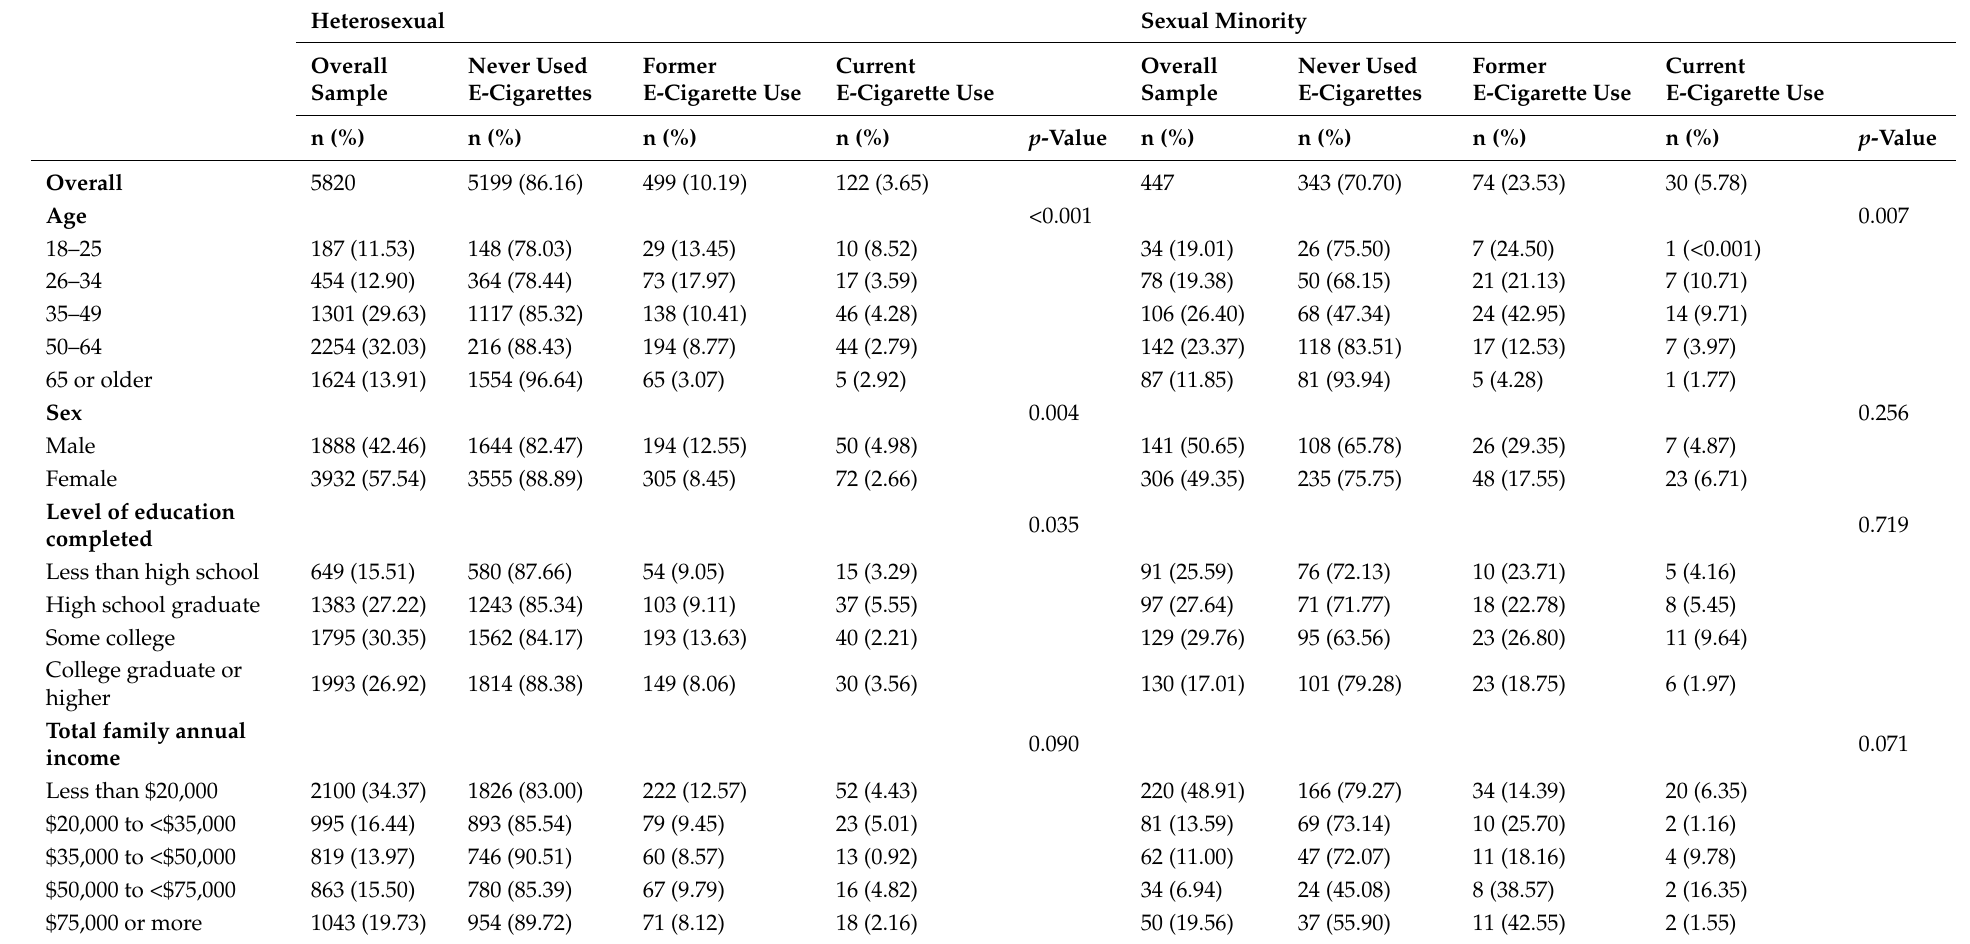
Table 1. The weighted prevalence of e-cigarette use stratified by sexual identity among Black/African American adults (n = 6267) by their sociodemographic characteristics and anxiety/depression